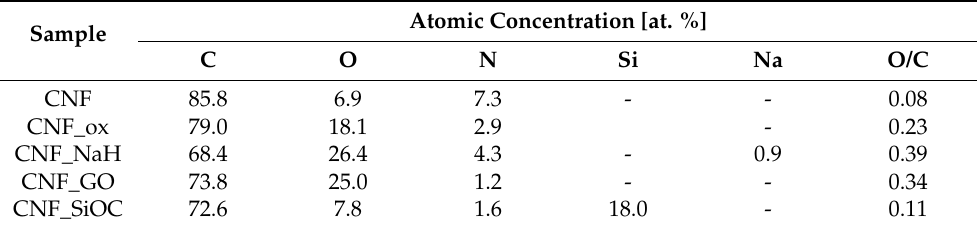
Table 2. Elemental composition of CNFs and modified CNFs obtained from XPS